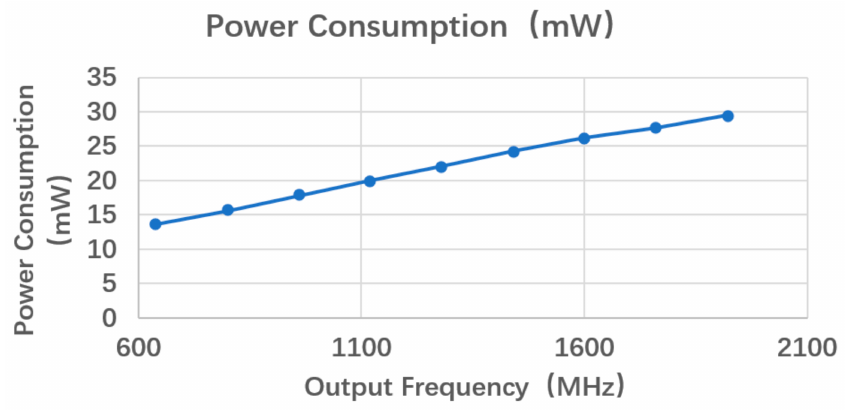
Figure 12. The power consumption of the NS-ADPLL.